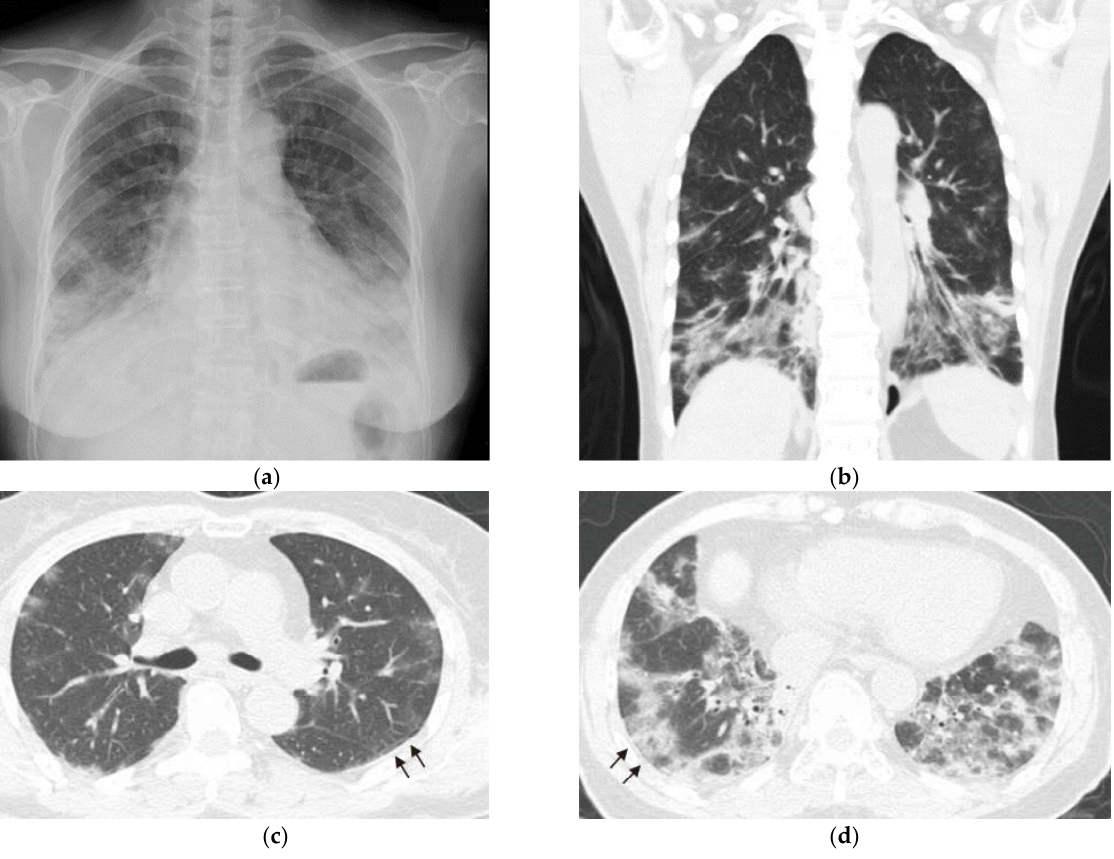
Figure 1. Chest imaging at initial presentation ( a ) Chest radiograph revealed reticular opacities and consolidations in bilateral lower lungs. ( b – d ) Computed tomography scans revealed subpleural spar- ing patterns (arrows) and multifocal ground-glass opacities in bilateral basal distribution, indicating nonspecific interstitial